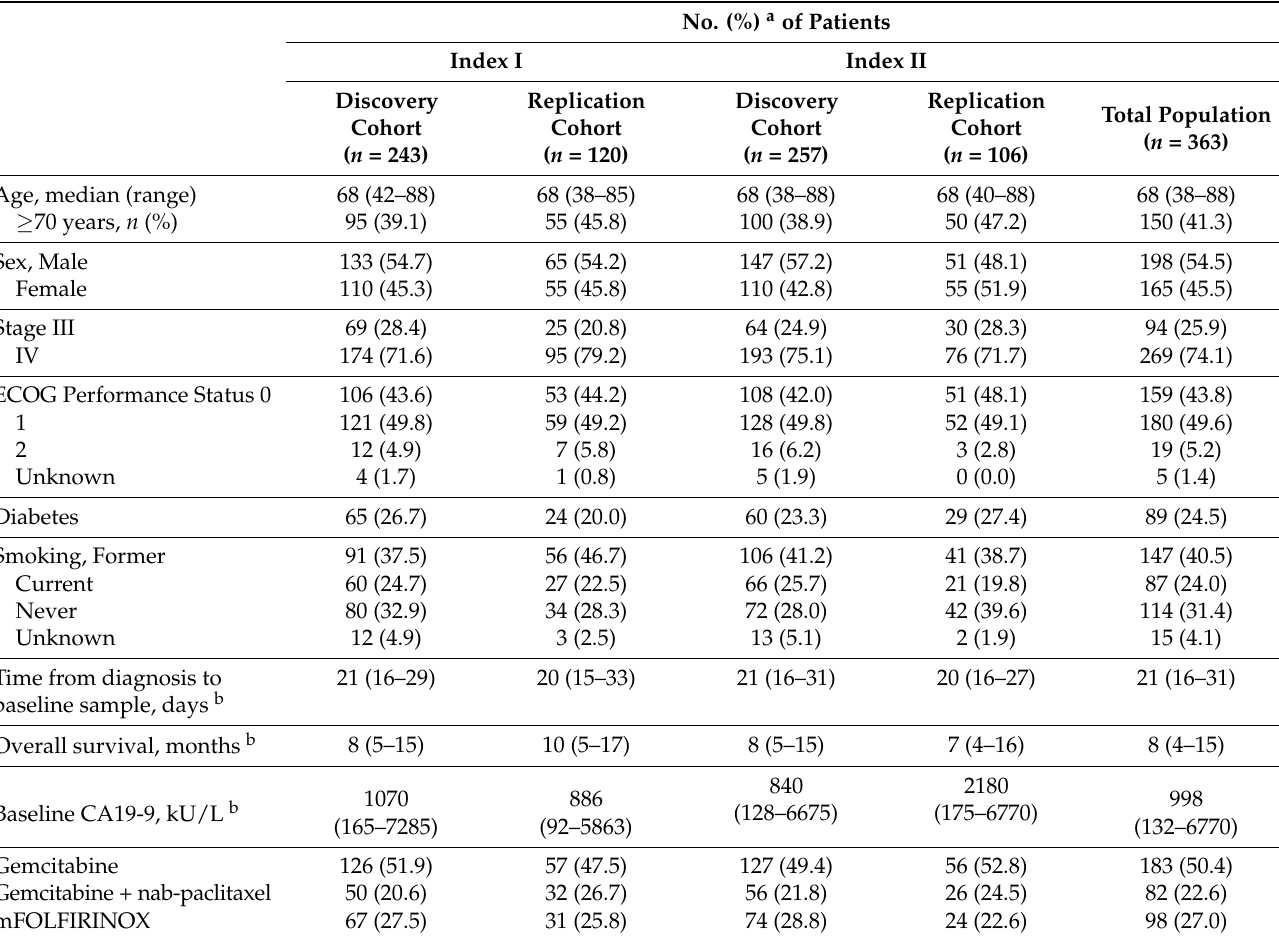
Table 1. Patient